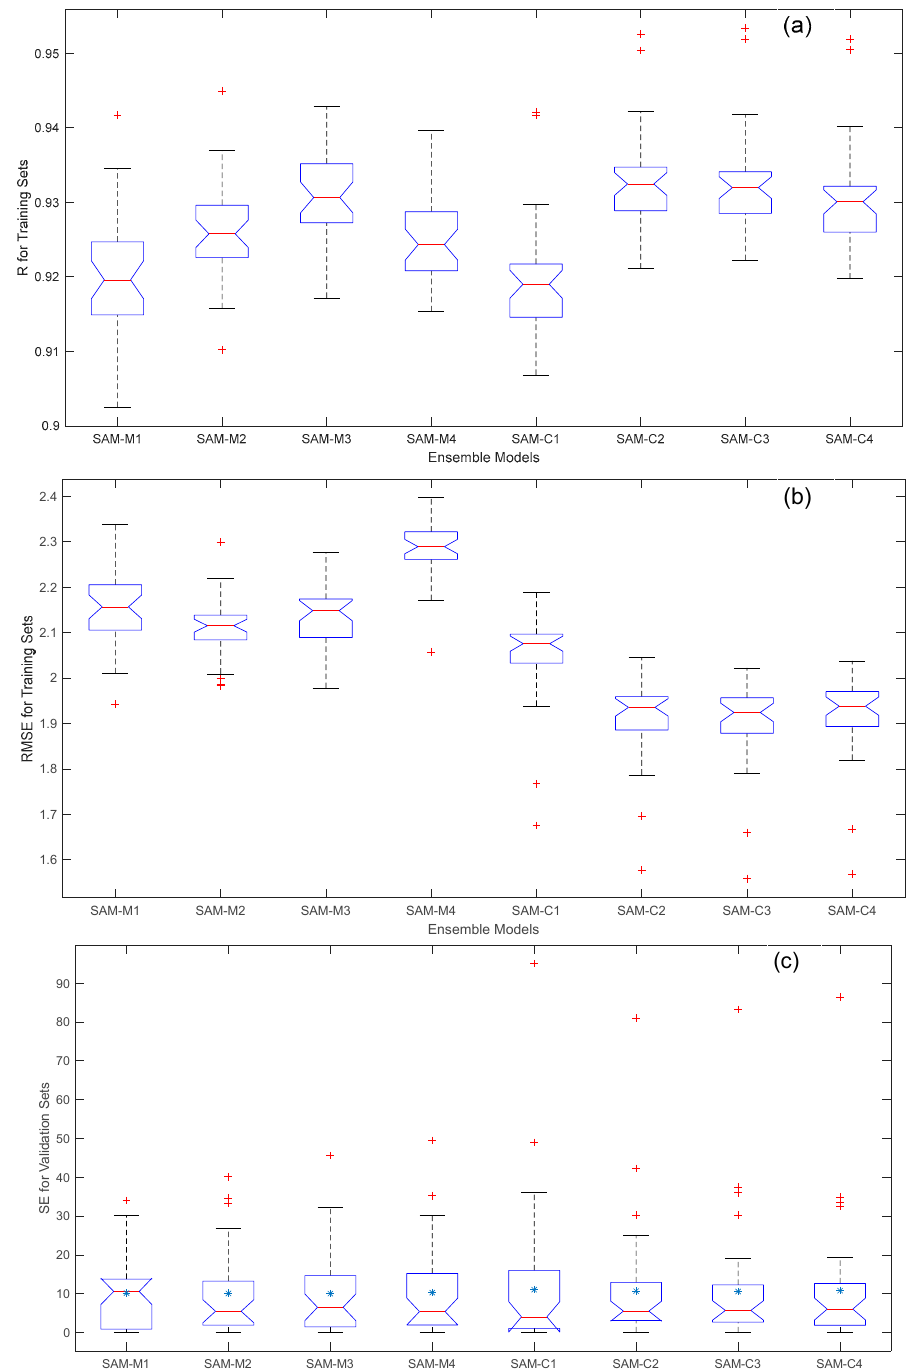
Figure 5. Performance of selected kNN-based stacking ensemble learning models using single-type distance functions. ( a ) R for training sets. ( b ) RMSE for training sets. ( c ) SE for validation sets.